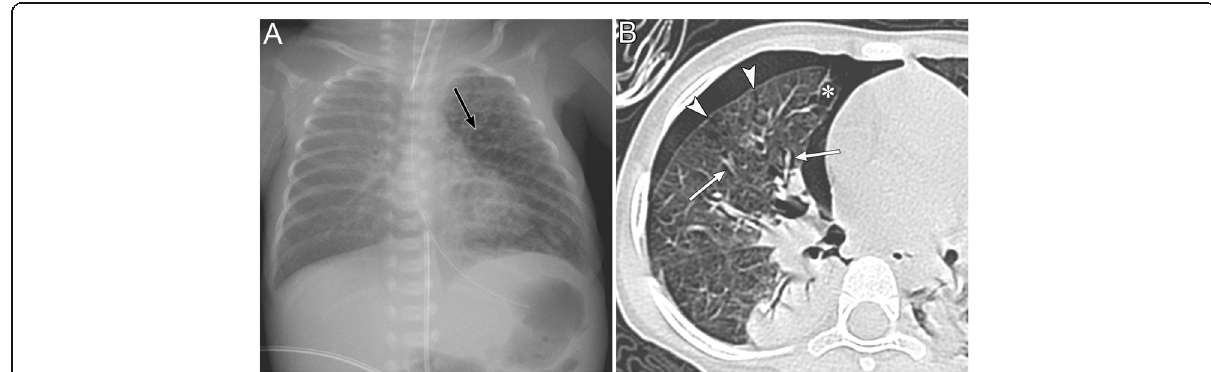
Fig. 21 Pulmonary interstitial emphysema. a A supine radiograph of a 6-day-old girl with an extremely low birth weight shows generalized irregular radiolucent mottling and perivascular air (black arrow) in the left lung. b An axial chest CT image of a different patient (a 20-month-old girl with pneumonia) shows a subpleural cyst (asterisk), air within the interlobular septa (arrowheads), perivascular and peribronchial emphysema (white arrows), and